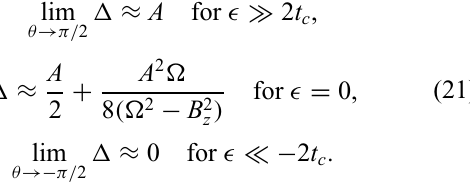
|˜↓ |˜↓ |˜↑ |˜↑ , ⇑(cid:3) , , ⇓(cid:3) , , ⇑(cid:3) , and , ⇓(cid:3)